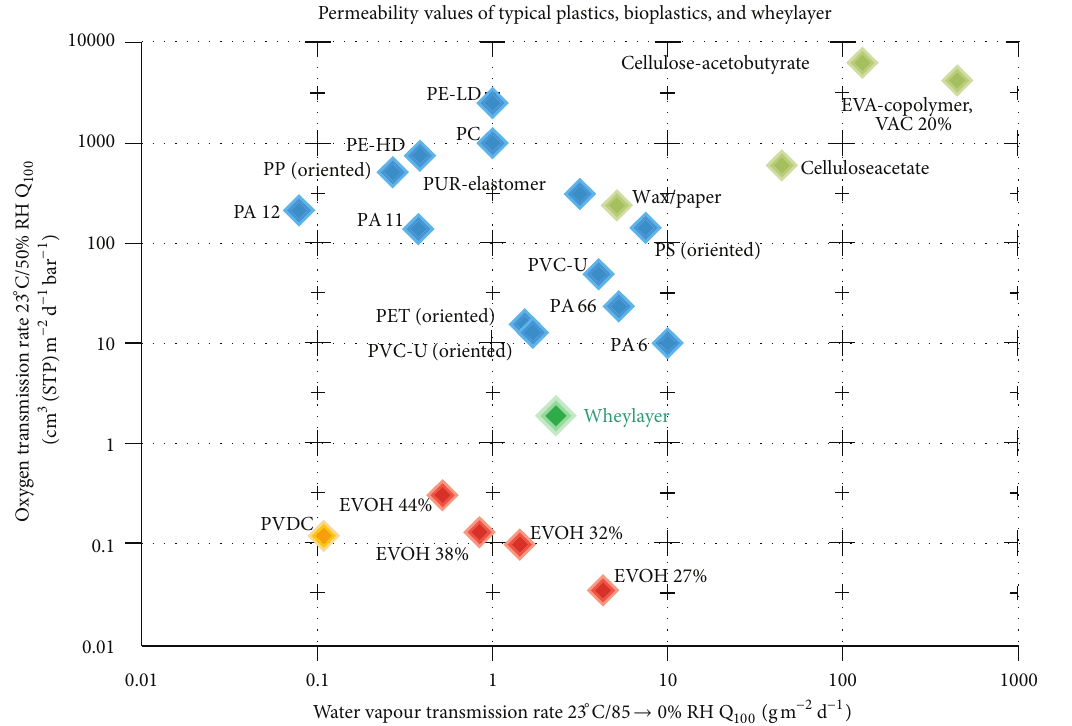
Figure 2: Barrier properties of whey-based layer versus other plastics commonly used in the packaging industry normalized to 100 𝜇 m.